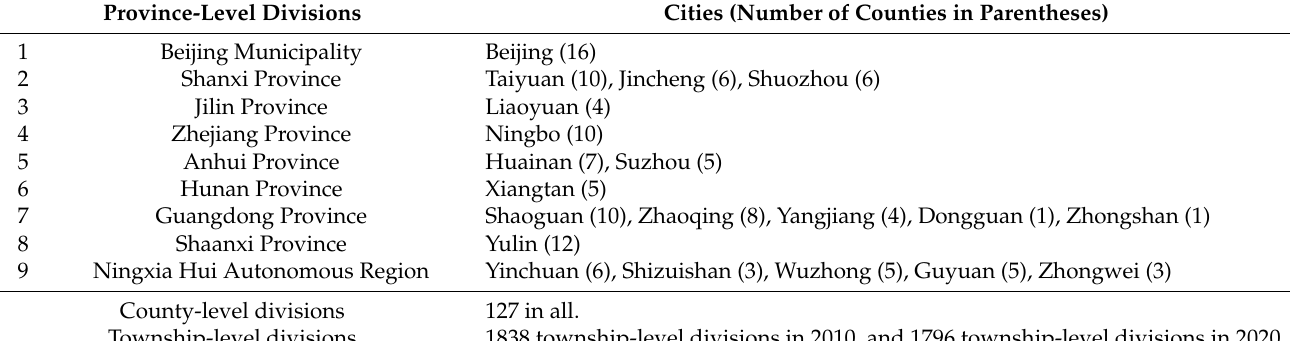
Table 2. List of counties and townships used to validate the results. The numbers of administrative units used for testing differ between 2010 and 2020, as the township-level divisions changed slightly between 2010 and